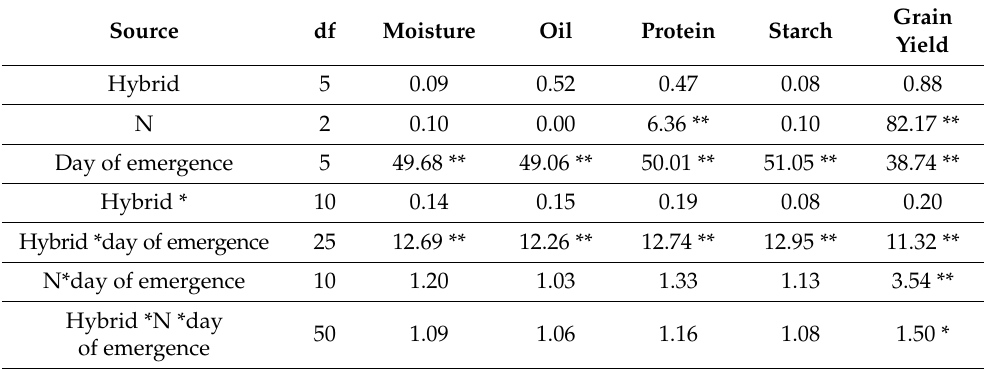
Table 2. Variance analysis of productivity parameters.